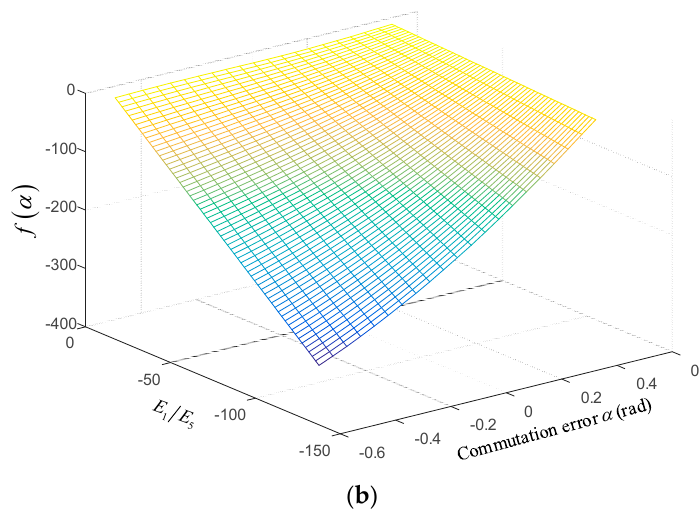
E E , and the commutation error  during the Figure 7. Relationships between f ( α ) , E 1 / E 5 , and the commutation error α during the freewheeling Figure 7. Relationships between   f  , 1 5 period t fw . ( a ) E 5 > 0; ( b ) E 5 < 0. t . ( a ) 0 E  ; ( b ) 0 E  . freewheeling period fw 5